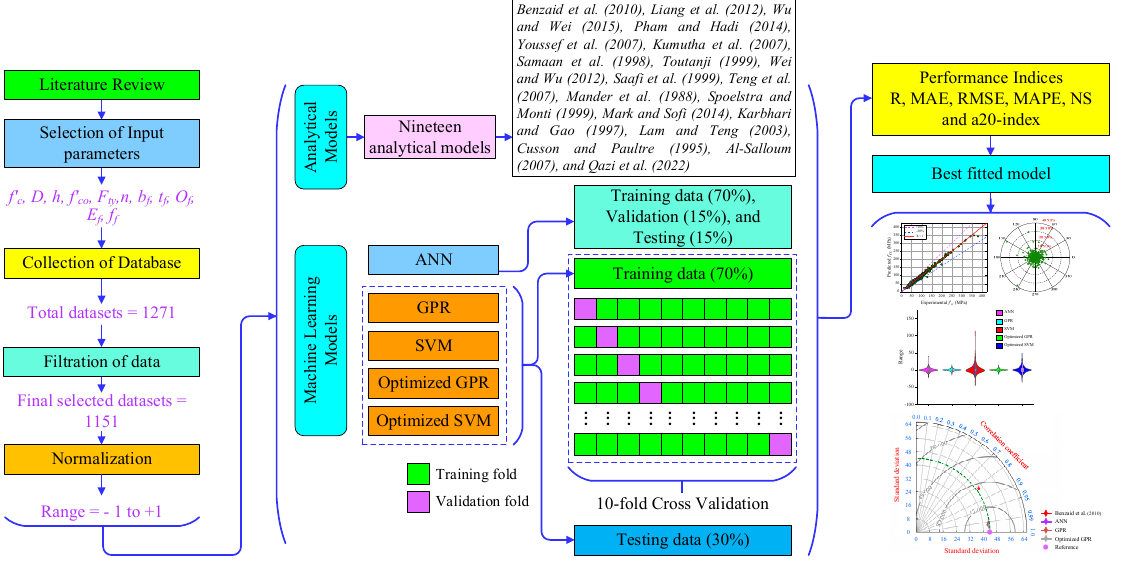
Figure 3. Methodology of this study (Benzaid et al. [48], Liang et al. [58], Wu and Wei [92], Pham and Hadi [93], Youssef et al. [94], Kumutha et al. [95], Samaan et al. [96], Toutanji [97], Wei and Wu [98], Saafi et al. [99], Teng et al. [100], Mander et al. [101], Spoelstra and Monti [102], Mark and Sofi [103], Karbhari and Gao [104], Lam and Teng [105], Cusson and Paultre [106], Al-Salloum [107], and Qazi et al.